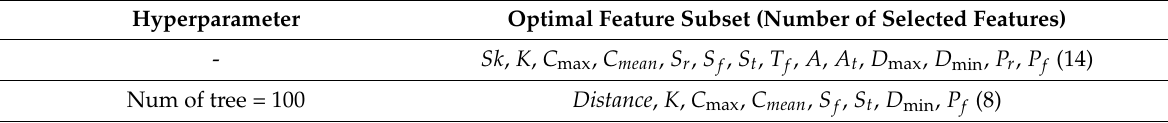
Table 8. Hyperparameter and optimal feature subset from RFECV of the spill mass predictor.